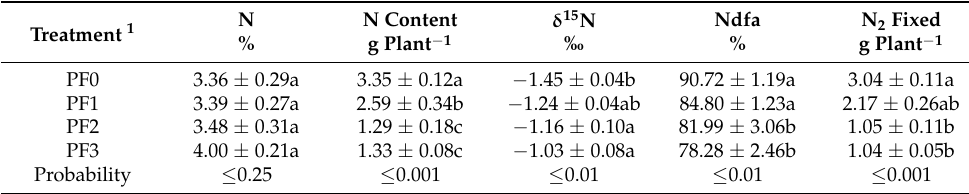
Table 5. Symbiotic performance (measured as %N, N content, δ 15 N, %Ndfa and N 2 fixed) of S. sesban as affected by pruning